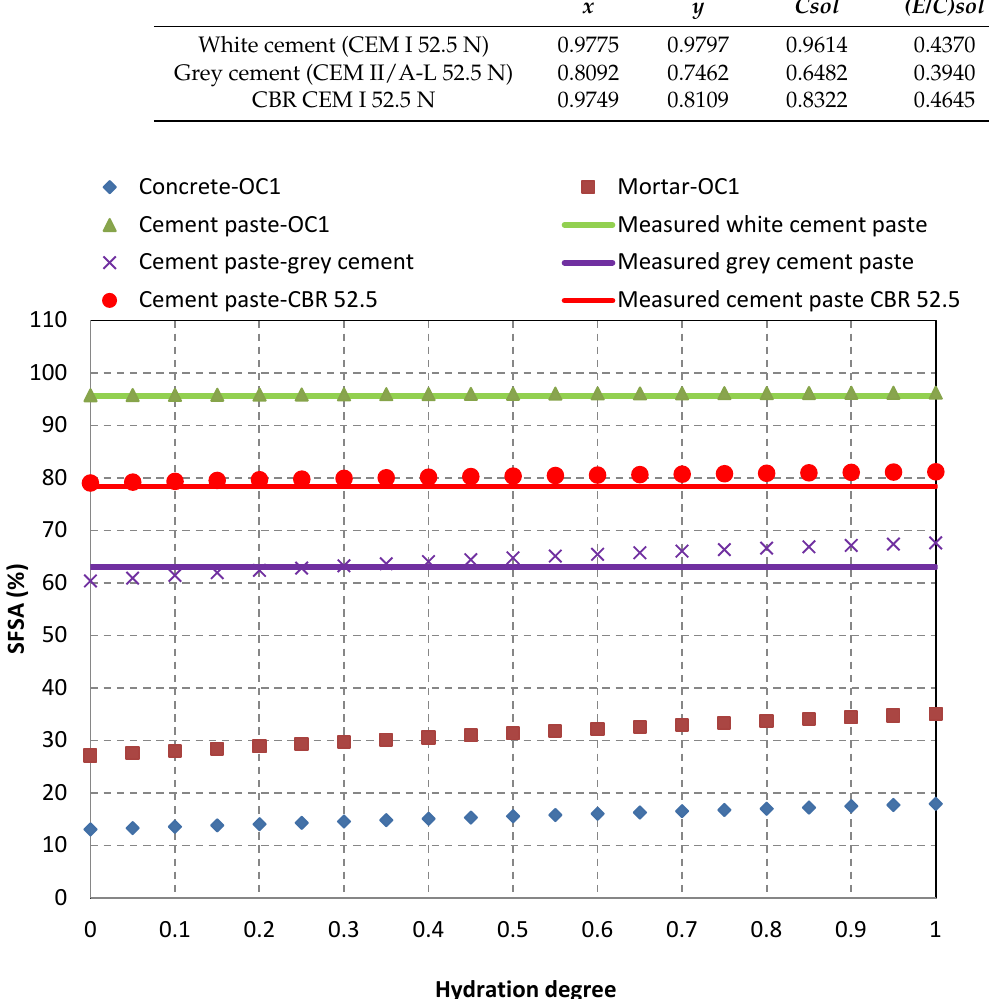
Figure 7. Variations of theoretical SFSA for pure grey cement paste, pure cement paste with CBR CEM I 52.5 N and for pure white cement-based paste, mortar of concrete OC1 and concrete OC1. Three horizontal solid lines show the comparison with the values obtained for the corresponding cement pastes.